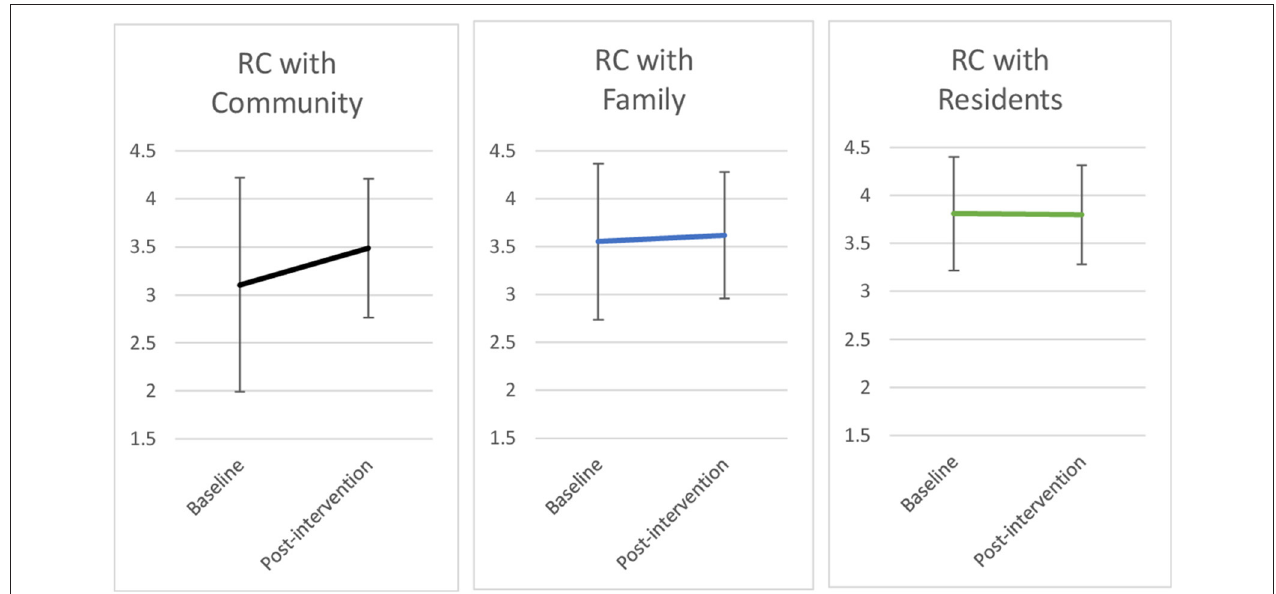
† † . Line graph shows changes in RC scores at baseline and post-intervention